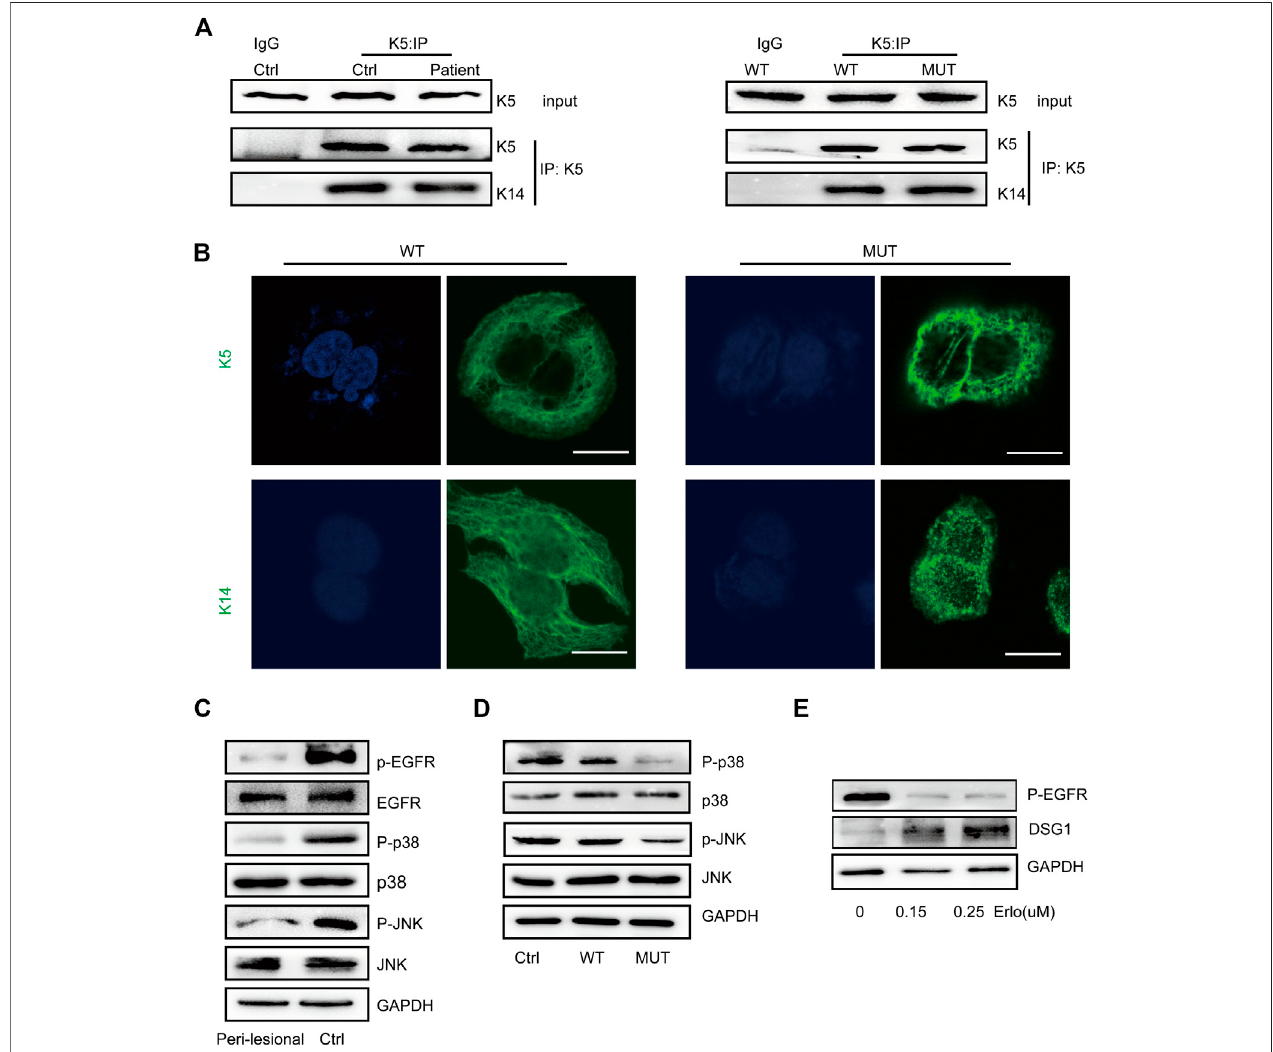
FIGURE3| K5maintainedkeratincytoskeletonandDSG1 via activatingMAPKsignaling. (A) K14wasco-precipitatedwithwild-typeandmutantK5inboth invivo and in vitro models. (B) K5 and K14 formed an intact keratin cytoskeleton in wild-type HaCaT cells, but the mutant K5 and K14 proteins aggregated around the nucleus. Bars, 10 µm. (C,D) A signi fi cant decreaseinMAPK signaling was observedin invivo and invitro models. (E) Immunoblot analysisshowed thatEGFR dephosphorylationinduced the upregulation of DSG1 expression levels in a concentration-dependent manner. GAPDH, loading control. Three biological replicates were conducted (A,C,D,E)